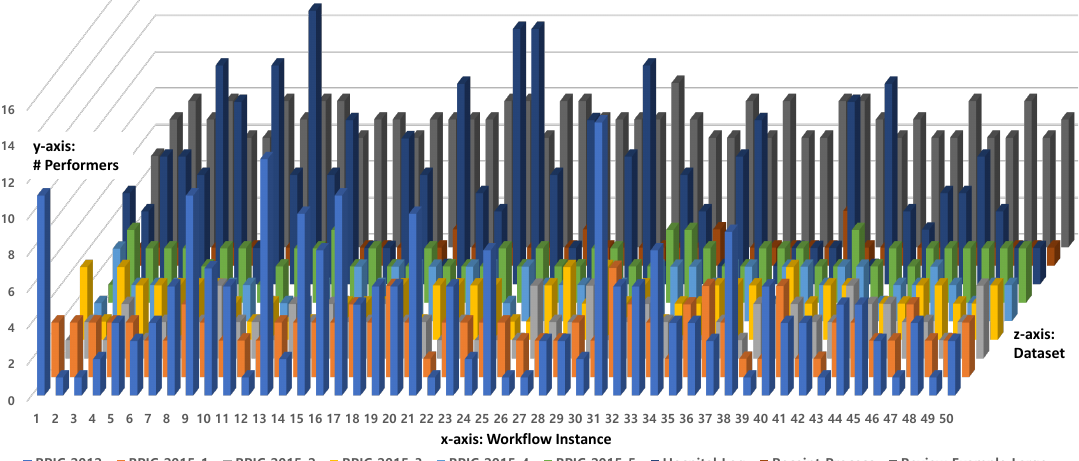
Figure 6. Summary of data cube of work transferences for each set of event traces mined from nine event log